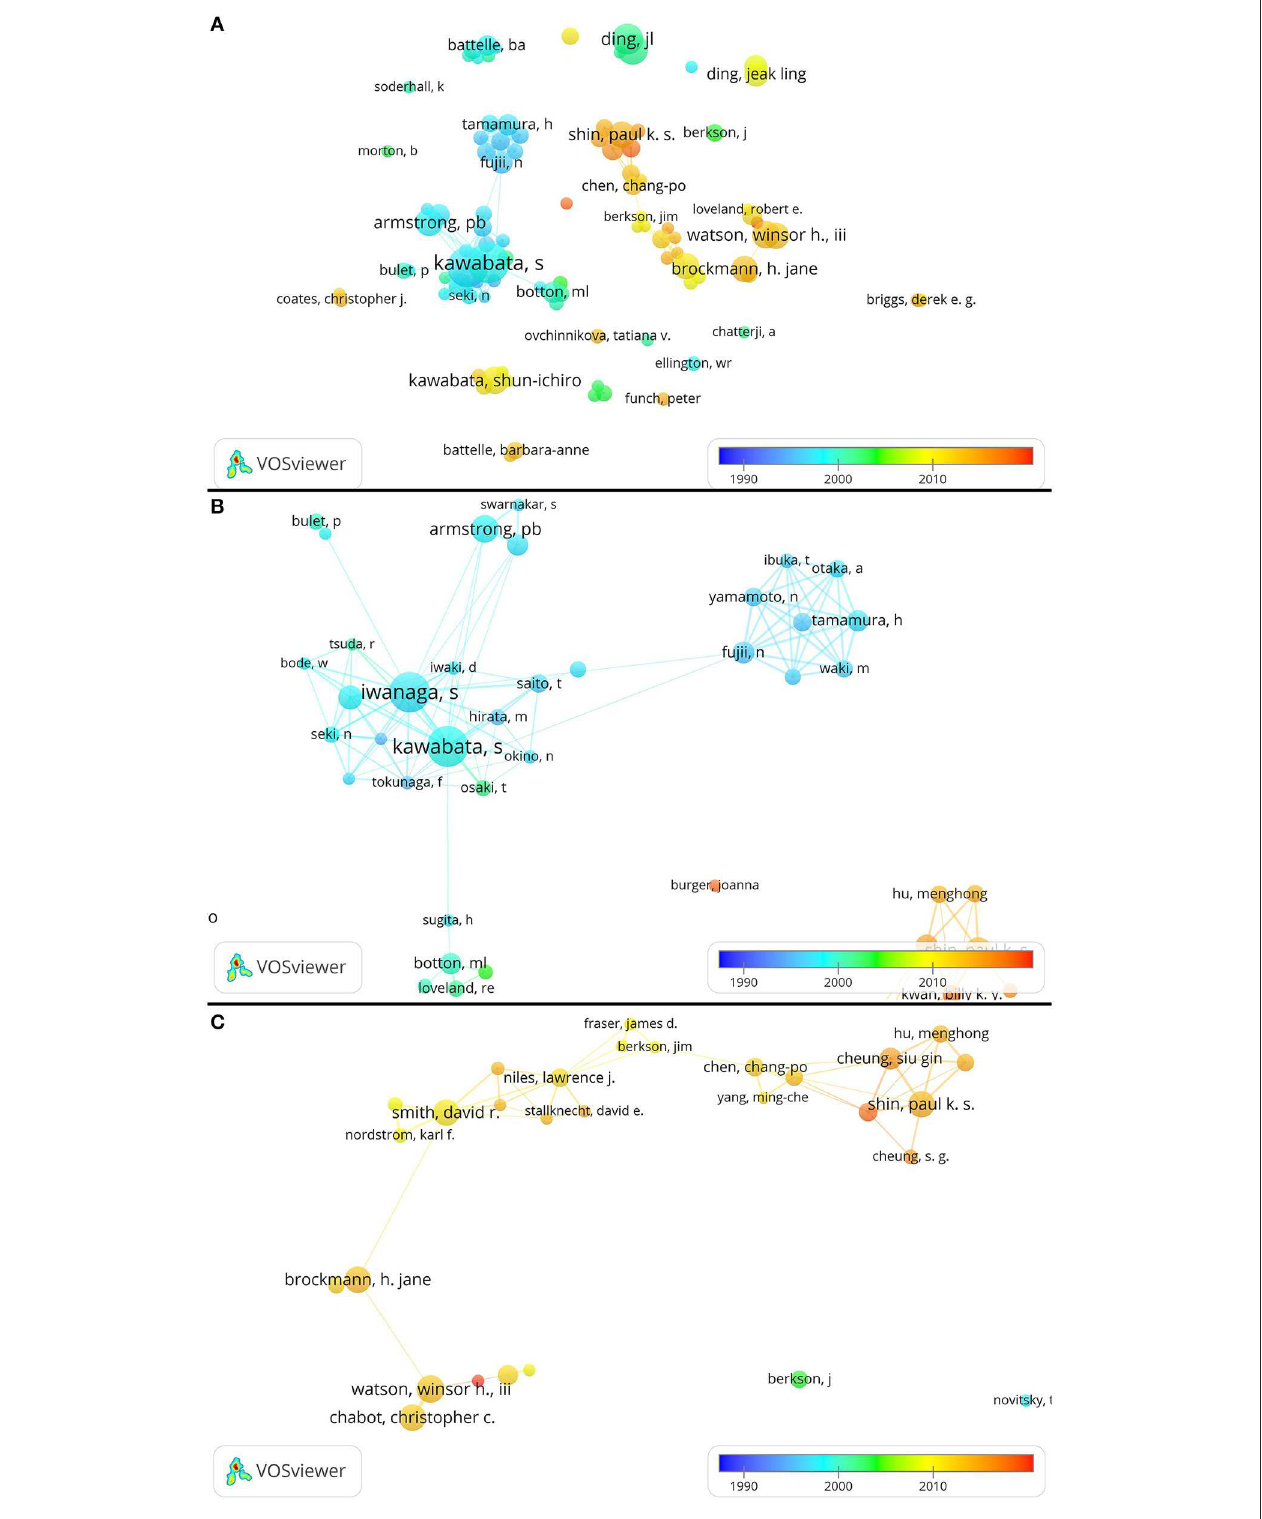
FIGURE 4 | Network showing cooperation among authors. (B,C) Are the zoomed-in results from (A) . Large dots indicate that authors have a high number of publications. The color of each dot represents when the publication is released. Thick lines between dots indicate cooperation among numerous authors. The same author may write her or his name in different ways. For example, in this figure, “ding, jl” and “ding, jeak ling” may refer to the same author.